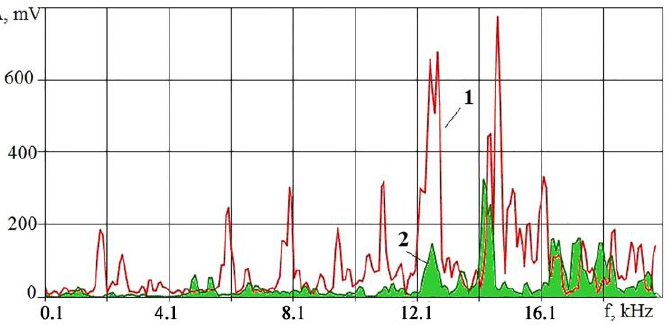
Figure 10. Comparison of the VA signals spectra in the range of 0.1–20 kHz when irradiating an aluminum insert (spectrum 1) and an insert coated with Ni77Cr23 film (spectrum 2).